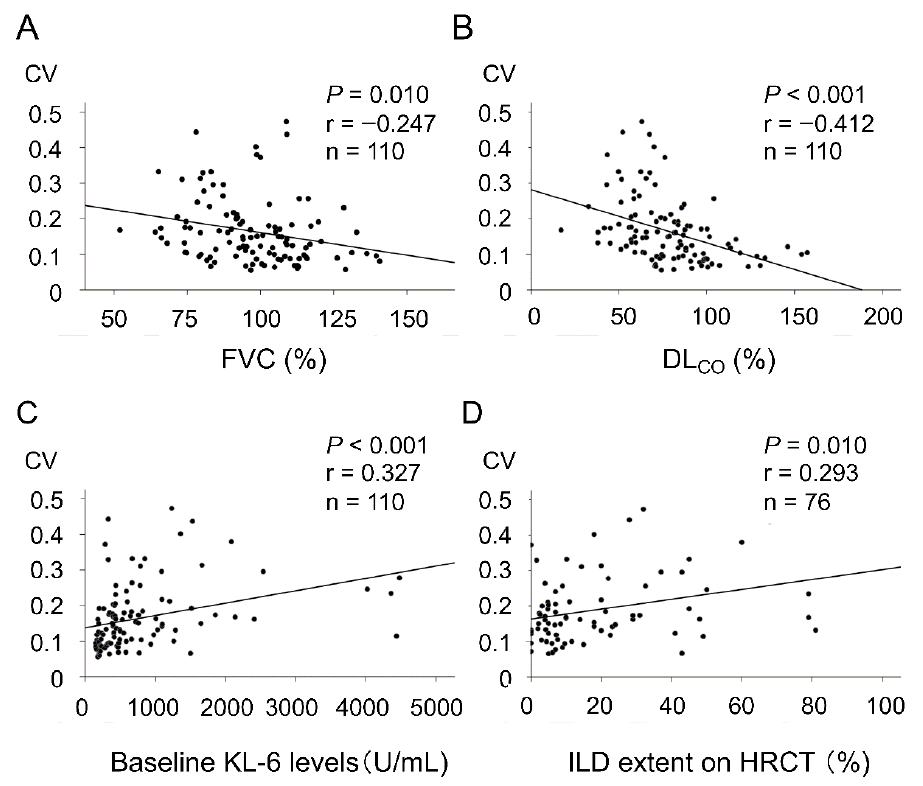
Figure 2. Correlations between the coefficient of variation (CV) of serial KL-6 level changes and ( A ) FVC, ( B ) DL CO and ( C ) baseline KL-6 levels in 110 patients with SSc or ( D ) ILD extent on HRCT in 76 patients who underwent chest HRCT at SSc diagnosis. Table 3. Baseline characteristics and immunomodulatory treatment between patients who experi- enced progression of ILD as defined by the OMERACT criteria 1 and those who did